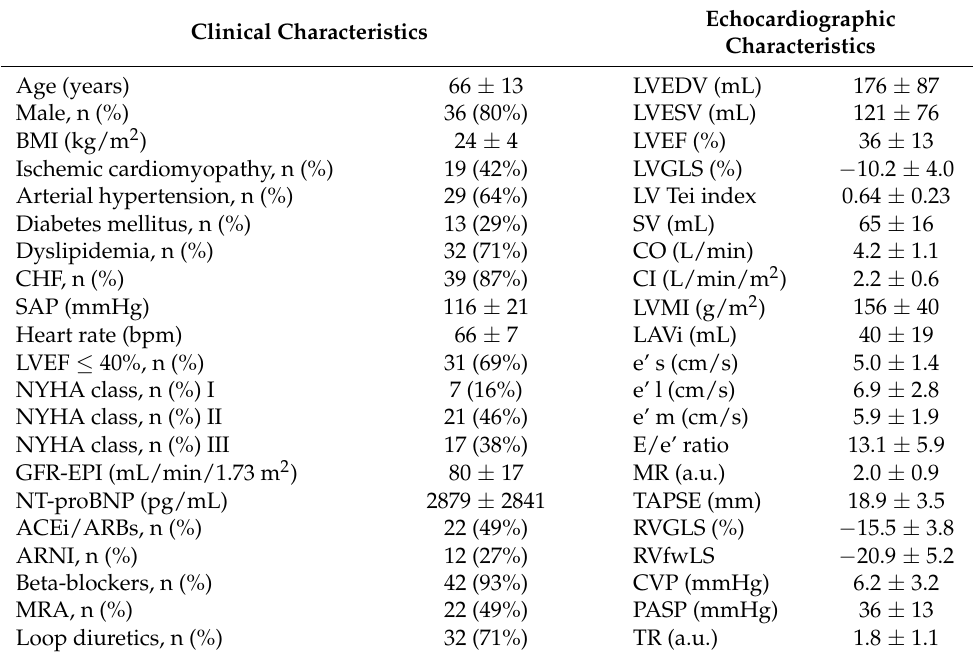
Table 1. Clincal and echocardiographic characteristics of the study